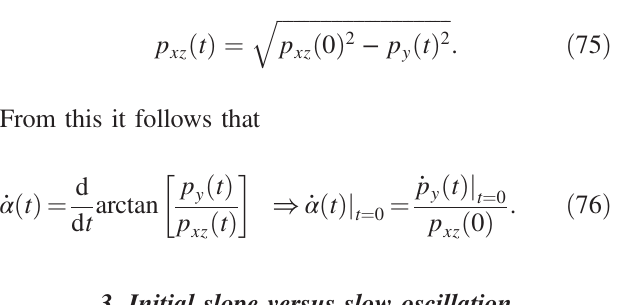
, and (b) relation between S x 0